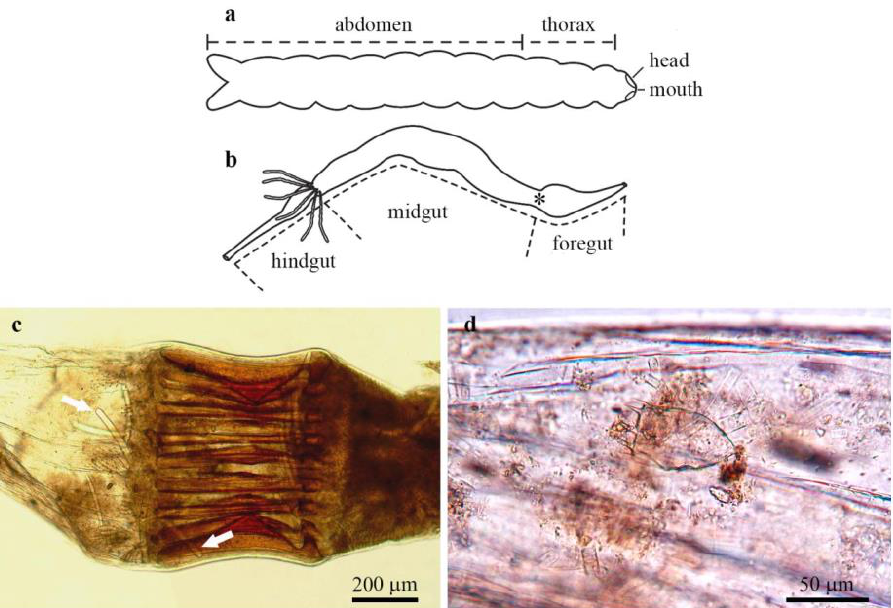
Figure 8. Amphipsyche meridiana (Trichoptera, Hydropsychidae) associated with Corvospongilla siamensis (Lower Mekong, Southeast Asia). ( a , b ) Scheme of body and digestive tract of the sponge-eating caddisfly larva (adapted from Sangpradub and Giller [27]). The position of the proventriculus (*) is indicated in ( b ). ( c ) Siliceous spicules with blunt tips (arrows) in the proventriculus. ( d ) Food debris in the midgut, i.e., diatoms and a rotifer.